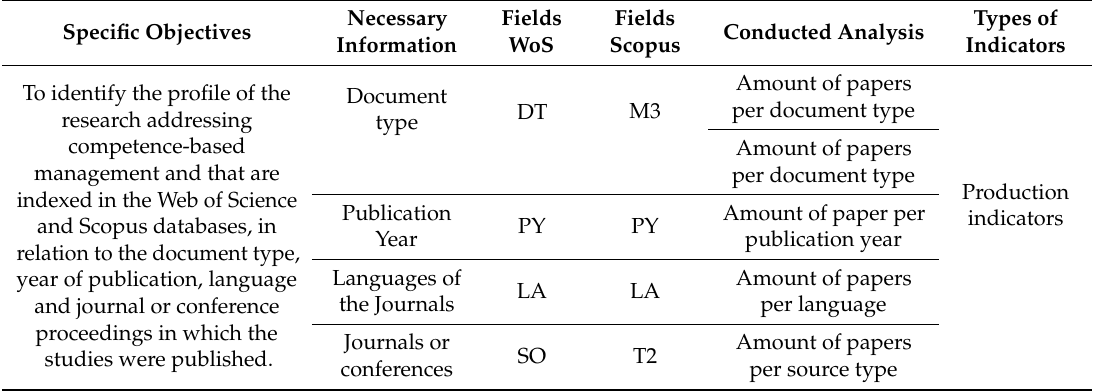
Table 2. Specific objectives, databases fields, and analysis